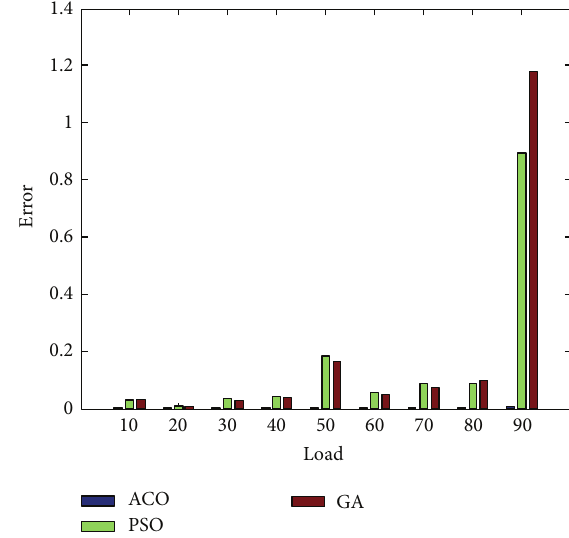
Figure 3: Error value graph.